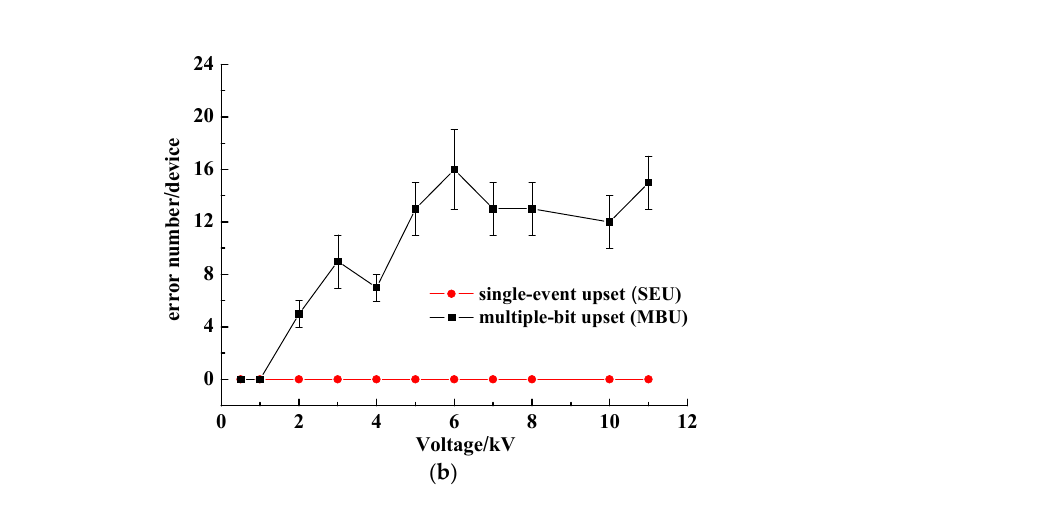
1 pattern, CB pattern and CBC pattern. The MBU is the major type of bit-error at high